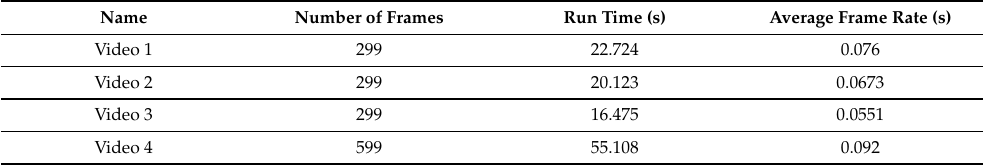
Table 24. Summary of timing analysis for each sample